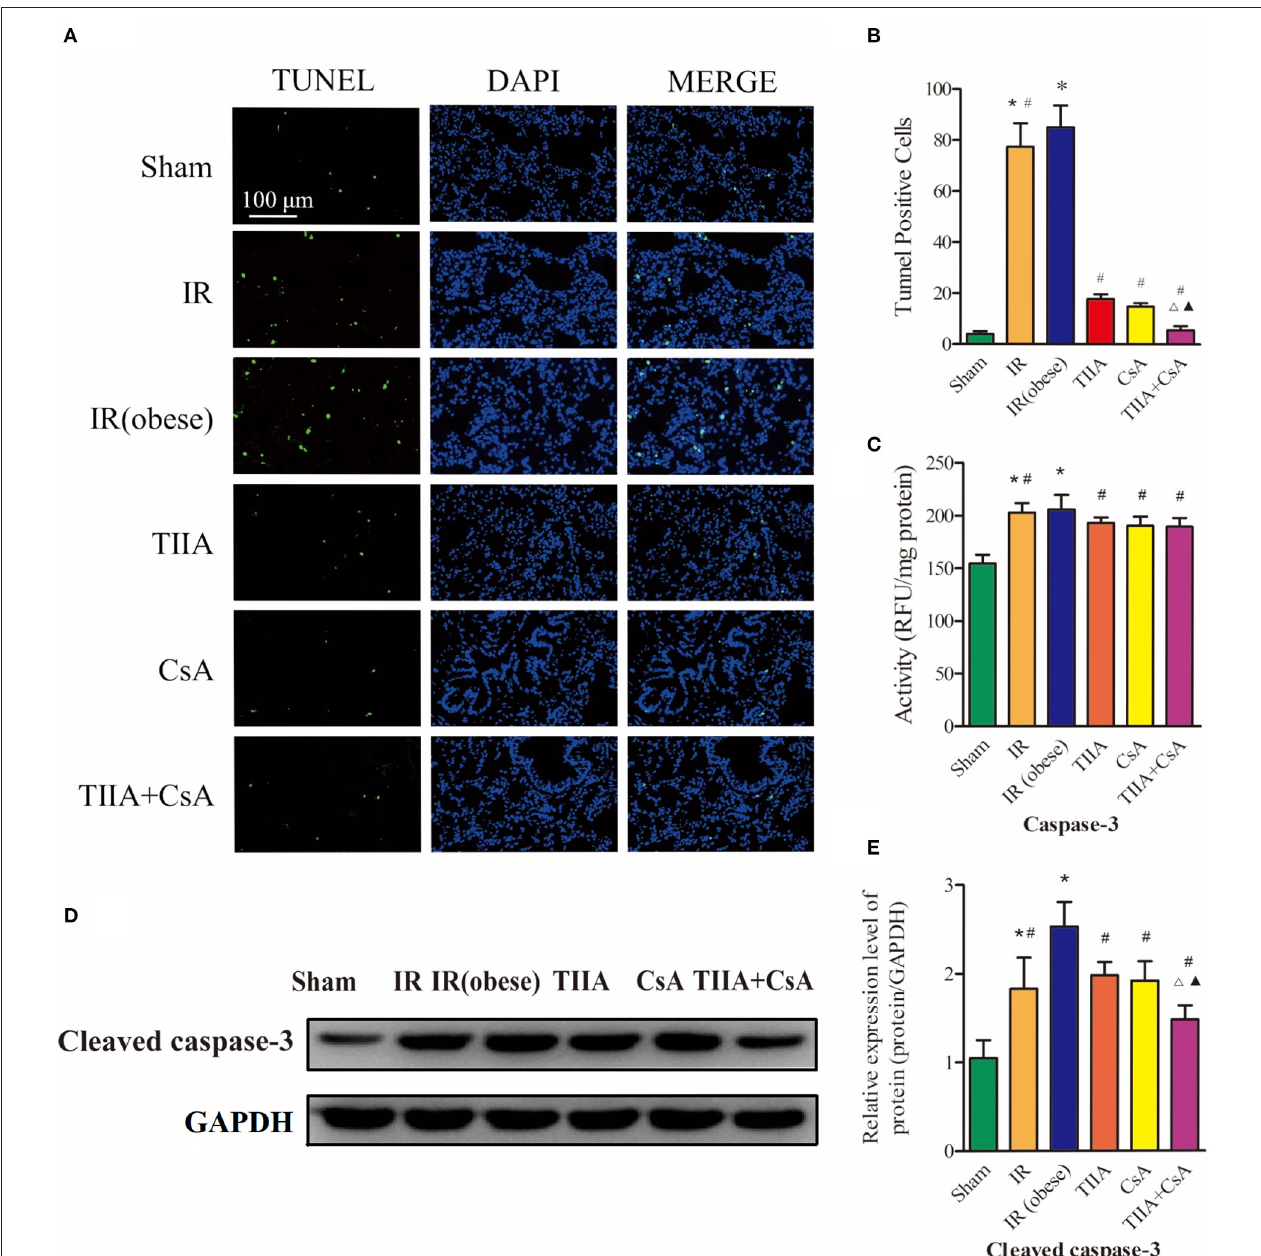
FIGURE 3 | Tanshinone IIA (TIIA) + cyclosporine A (CsA) inhibited lung cells apoptosis after renal ischemia-reperfusion (IR). (A) Lung apoptosis with TUNEL; (B) TUNEL-positive cells in lung; (C) caspase-3 activity. Rats were pretreated with TIIA alone or in combination with CsA followed by removing the right kidney and clamping of the left renal artery for 30min and reperfusion for 24h. Sham rats were used as control. Representative apoptosis of lung cells (A) and TUNEL-positive cells (B) were evaluated under different conditions. The scale bars represent a length of 100 µ m on histology. The activity of myocardial caspase-3 (C) , the protein expression of cleaved caspase-3 (D) , and the protein expression of cleaved caspase-3 (E) were evaluated in different groups. Data are shown as mean ± SD. * p < 0.05 vs. sham group, # p < 0.05 vs. IR (obese) group, 1 p < 0.05 vs. TIIA group, N p < 0.05 vs. CsA